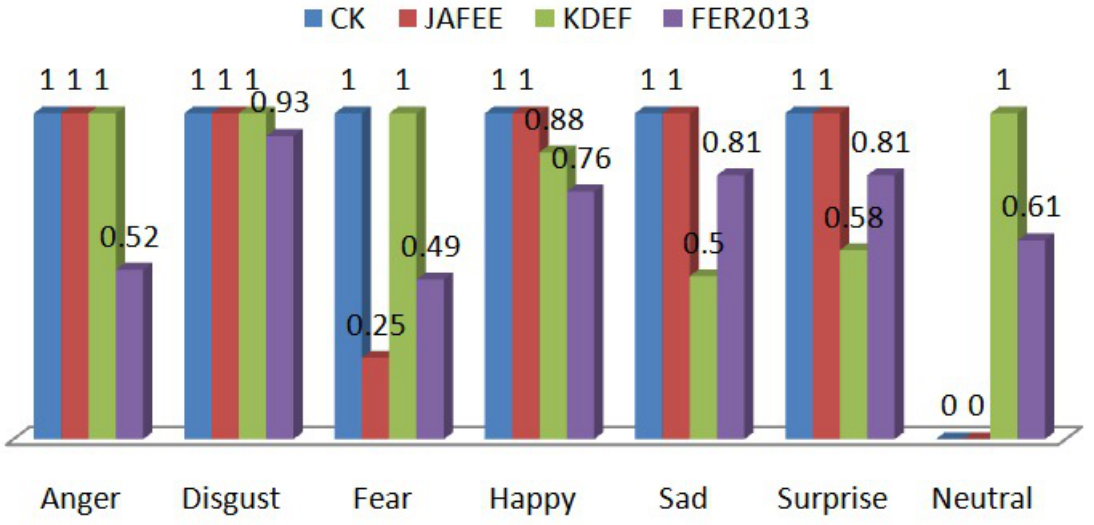
Figure 10. Precision for CK+, JAFFE, KDEF and FER2013